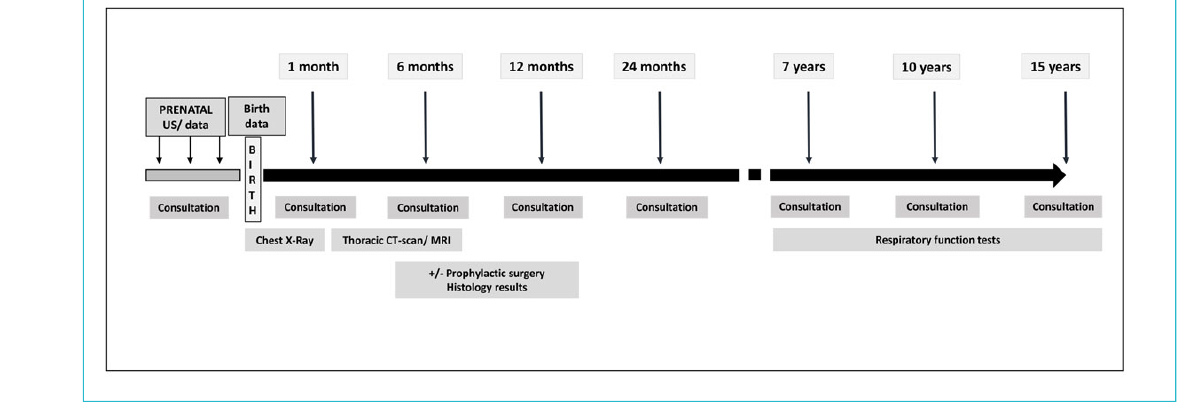
Figure 4: Data recorded at different stages of a congenital lung anomaly patient’s follow-up during